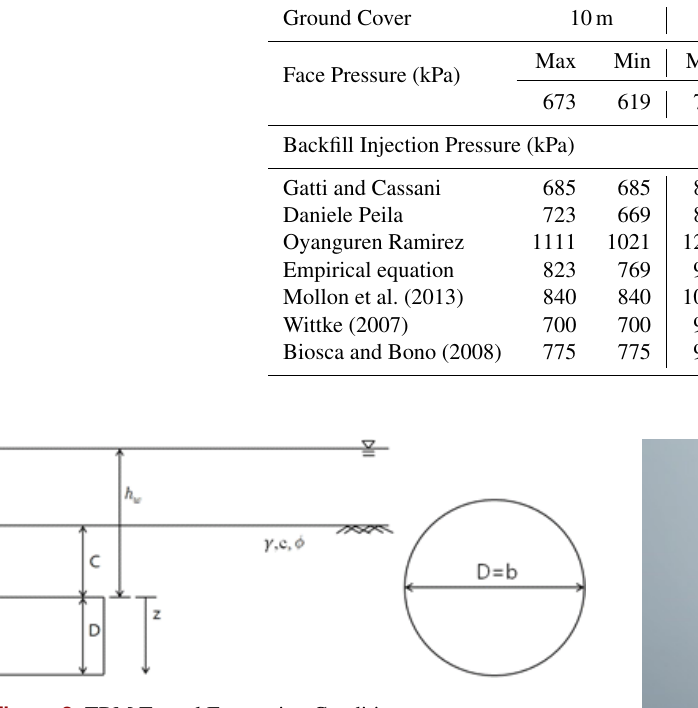
Figure 2. TBM Tunnel Excavation Conditions.